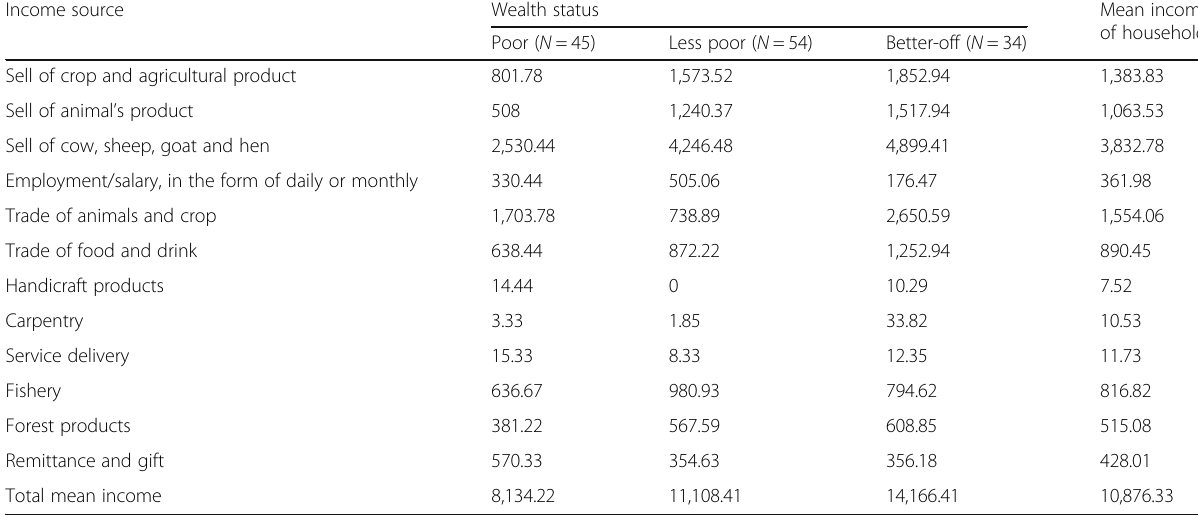
Table 2 Income of the household from different sources in Birr ( N = 133) Income